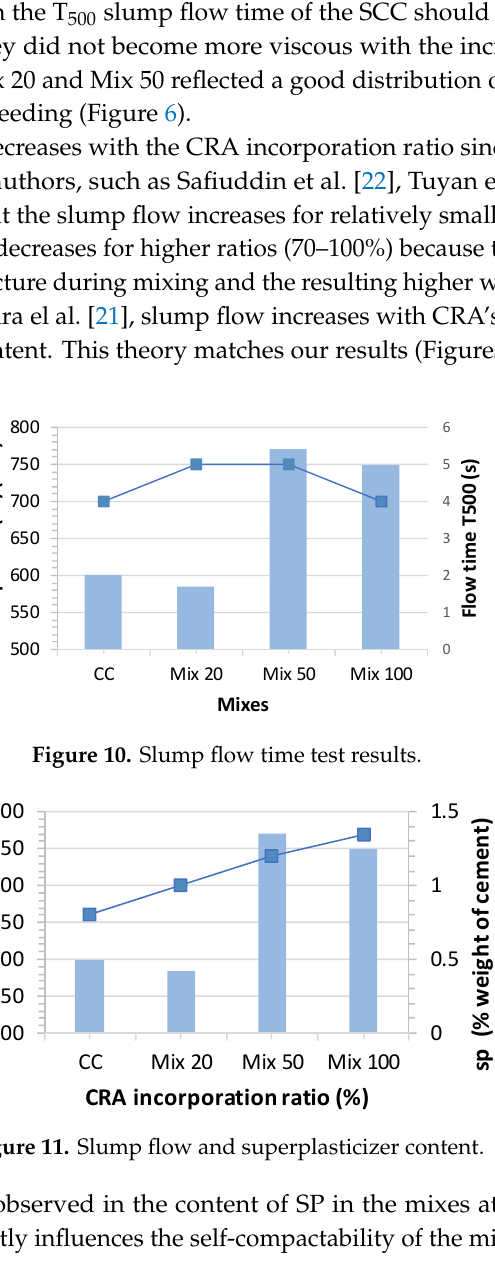
Figure 9. Passage capacity test results.